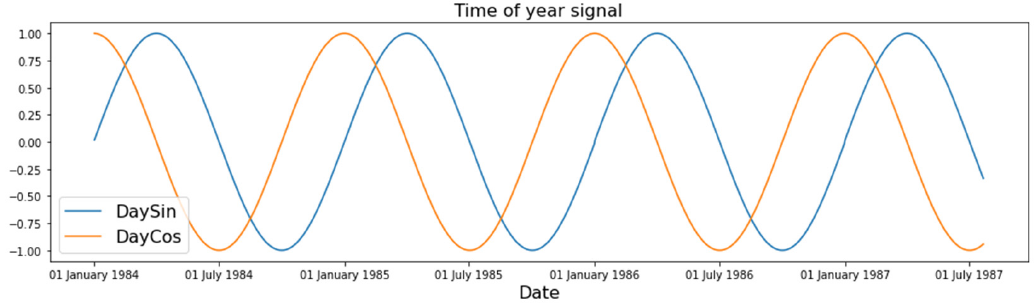
Figure 2. Visualization of visible correlations between weather variables and solar irradiance.